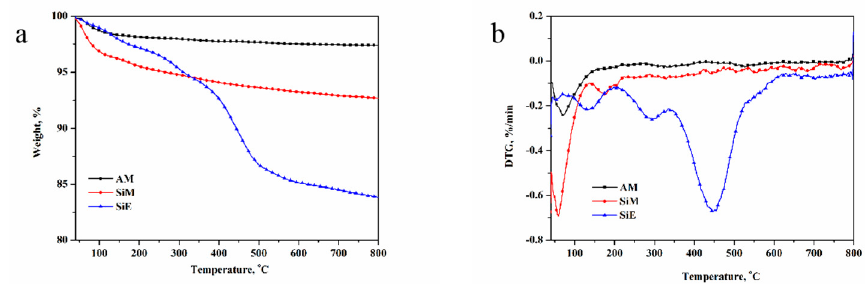
Figure 9. Thermogravimetric (TG) ( a ) and DTG curves ( b ) of AM, SiM, and SiE.